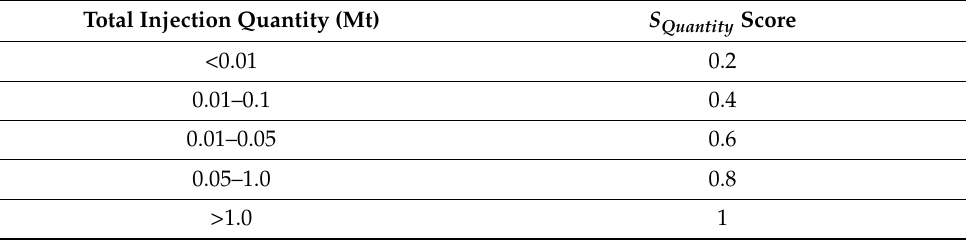
Table 6. The assessment rules of the injection